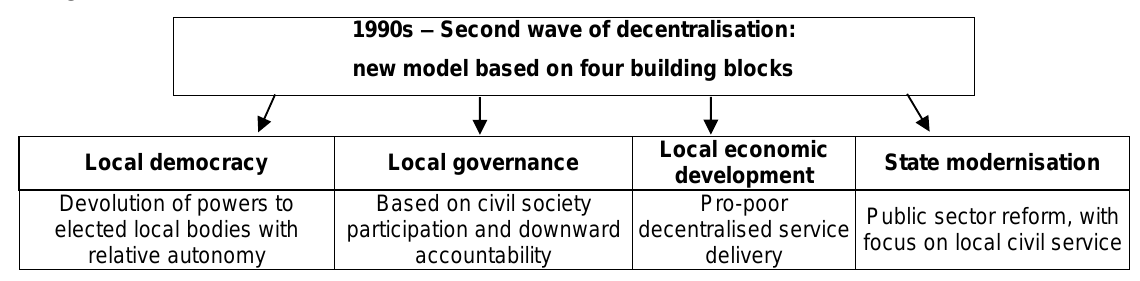
Figure 1: Decentralisation and state reform 1990s – Second wave of